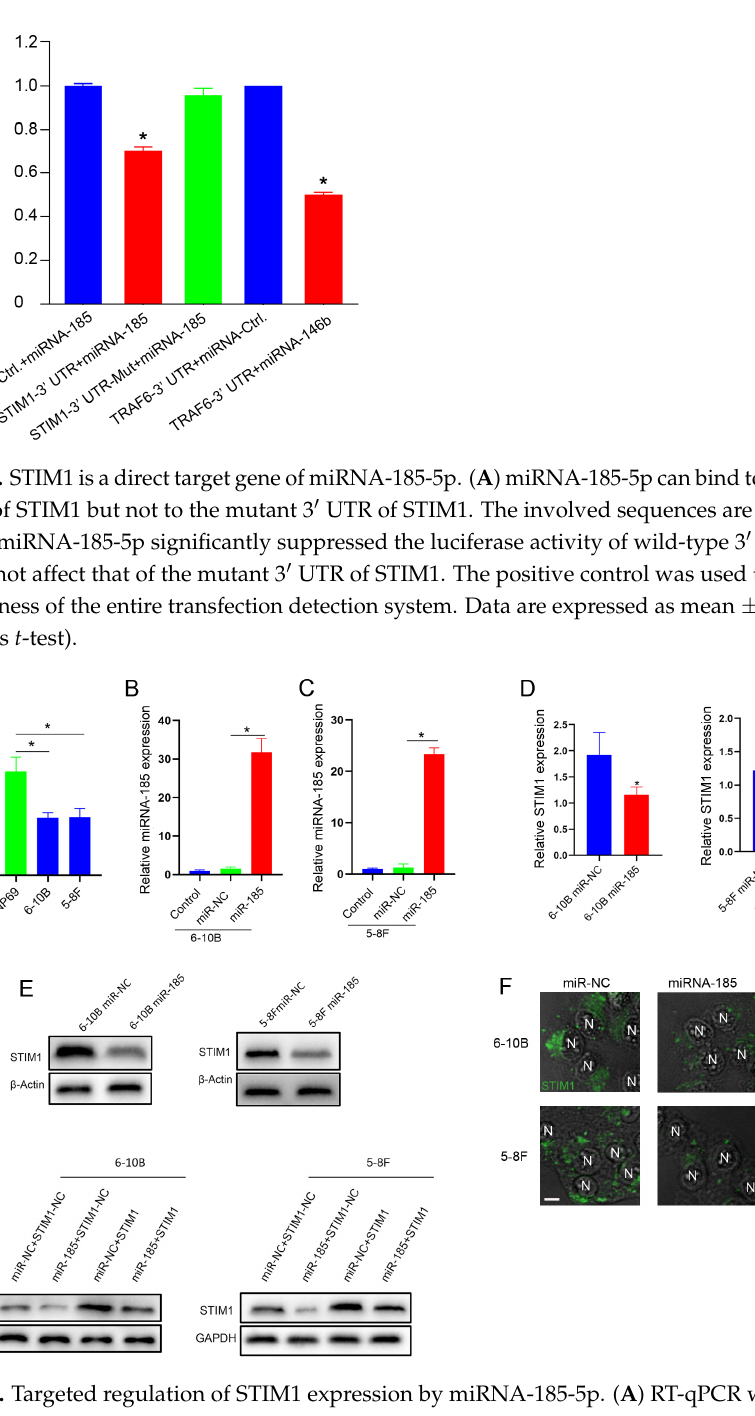
Figure 5. Targeted regulation of STIM1 expression by miRNA-185-5p. ( A ) RT-qPCR was performed to determine the relative expression of miRNA-185 in a nasopharyngeal epithelial cell line NP69, and the two NPC cell lines 6–10B and 5–8F. ( B ) Quantitative analysis of miRNA-185 levels in the indicated groups assessed by RT-qPCR. ( C ) Quantitative analysis of miRNA-185 levels in the indi- cated groups assessed by RT-qPCR. ( D ) Quantitative analysis of STIM1 levels in 6–10B or 5–8F cells overexpressing miRNA-185 assessed by RT-qPCR. ( E ) Expression of STIM1 in 6–10B or 5–8F cells overexpressing miRNA-185 was assessed using Western blotting. ( F ) Aggregation of intracellular STIM1 was detected in 6–10B or 5–8F cells overexpressing miRNA-185 with immunofluorescence staining. Bar = 10 μ m. ( G ) The rescue experiment was carried out to confirm the targeted regulation of STIM1 by miRNA-185 in 6–10B or 5–8F cells. The levels of proteins were assessed using Western blotting. Data are expressed as mean ± SD of three independent experiments. (* p < 0.05, Student’s t -test). 3. Discussion The concentration of Ca 2+ in the cytoplasm is strictly controlled within a specified range to accurately transfer extracellular signals into the cytoplasm [14]. SOCE is a domi- nant pathway in the generation of calcium signals in non-excitable cells and maintains cytosolic Ca 2+ homeostasis, together with ATP-Ca 2+ pumps on the endoplasmic reticulum (ER) membrane and plasma membrane [15,16]. The dysregulation of SOCE-mediated Ca 2+ signaling is implicated in various malignant phenotypes of human cancer cells, including proliferation, invasion, metastasis, immune escape, tumor-associated angiogenesis, EMT, and drug resistance [17–22]. STIM1, an intracellular Ca 2+ sensor, serves as a key compo- nent of SOCE. The depletion of ER Ca 2+ induces STIM1 to accumulate intracellularly, which is then further transported to the ER-plasma membrane junction, where it directly binds and activates the opening of ORAI1 channels, subsequently triggering a Ca 2+ influx [23,24]. STIM1 is upregulated in various human malignancies, including liver, breast, cer- vical, and colon cancers [19,24–26]. We previously demonstrated that STIM1 is actively expressed in primary NPC tissues and associated with the degree of regional lymph node metastasis (N stage) [12]. Abnormally expressed STIM1 disrupts the dynamic balance of intracellular Ca 2+ by enhancing the SOCE activity, thus triggering the malignant transfor- mation of tumor cells, such as the switch from E- to N-cadherin shown in our study.